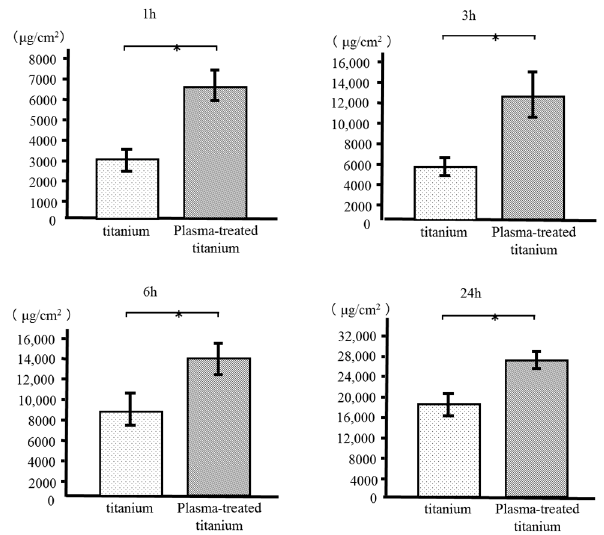
Figure 6. Rat bone marrow (RBM) cell adhesion of titanium and plasma-modified titanium. Plasma-treated titanium disks showed greater RBM cell adhesion than the titanium disk surfaces at every time point.